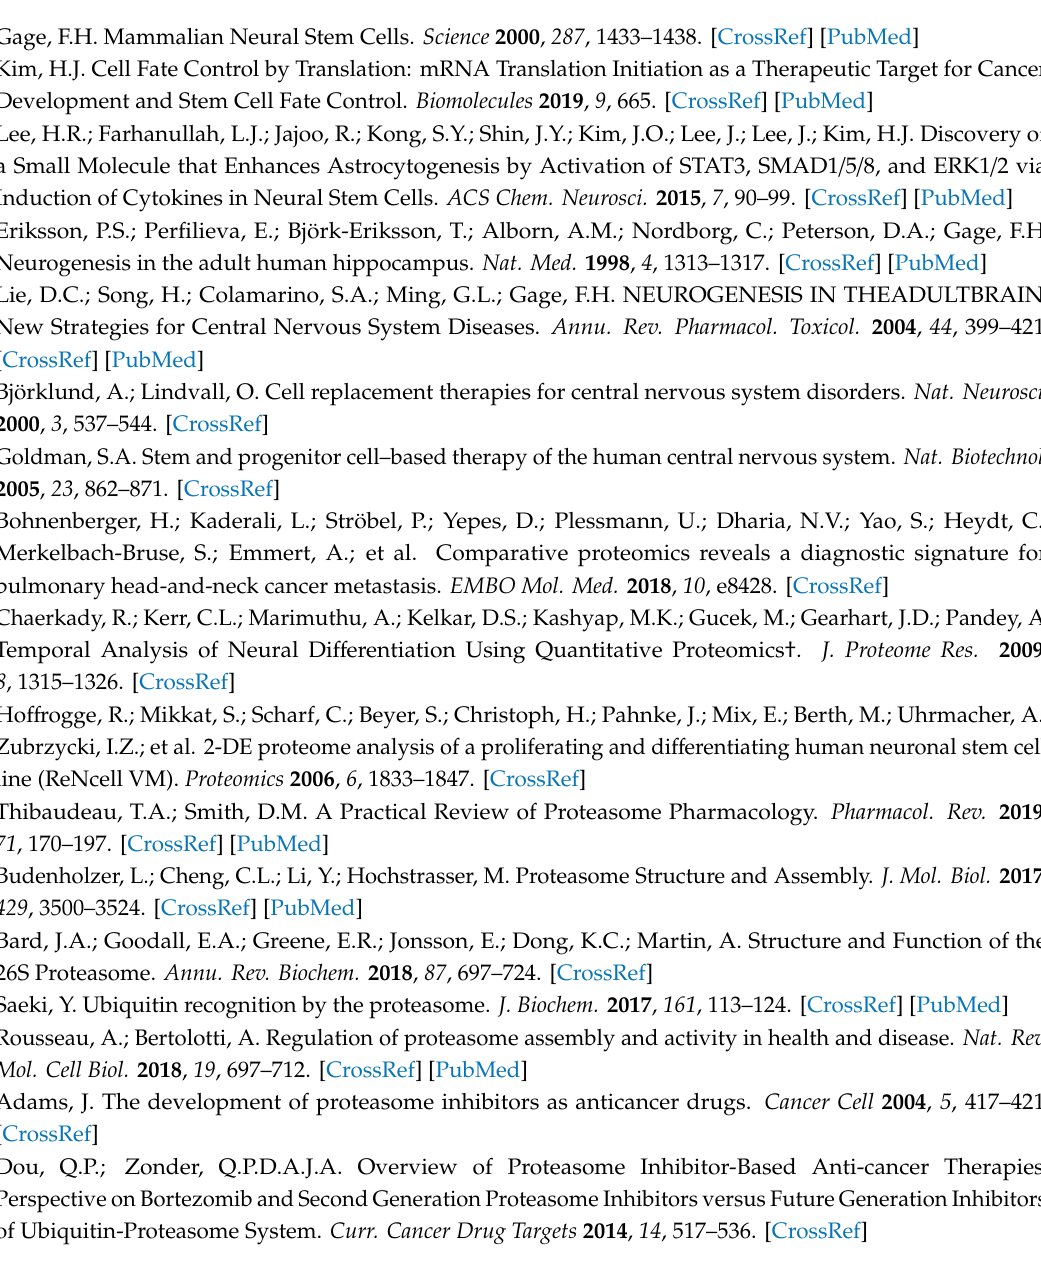
Figure S1: Uncropped 3 batches image of western blots for the TUBB3 and GFAP, Figure S2: Uncropped 3 batches image of western blots for the Bcl-2 and Bax, Figure S3: Uncropped 3 batches image of western blots for the p-CREB, Figure S4: Uncropped 3 batches image of western blots for the